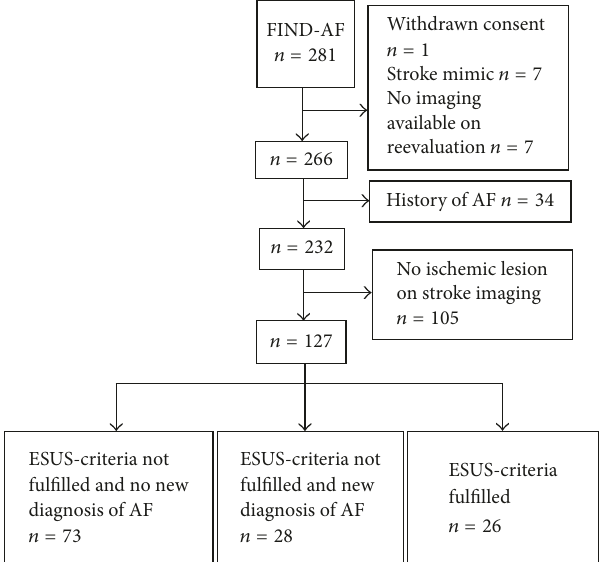
Figure 1: Study flow chart of included patients in this imaging substudy of the Find-AF